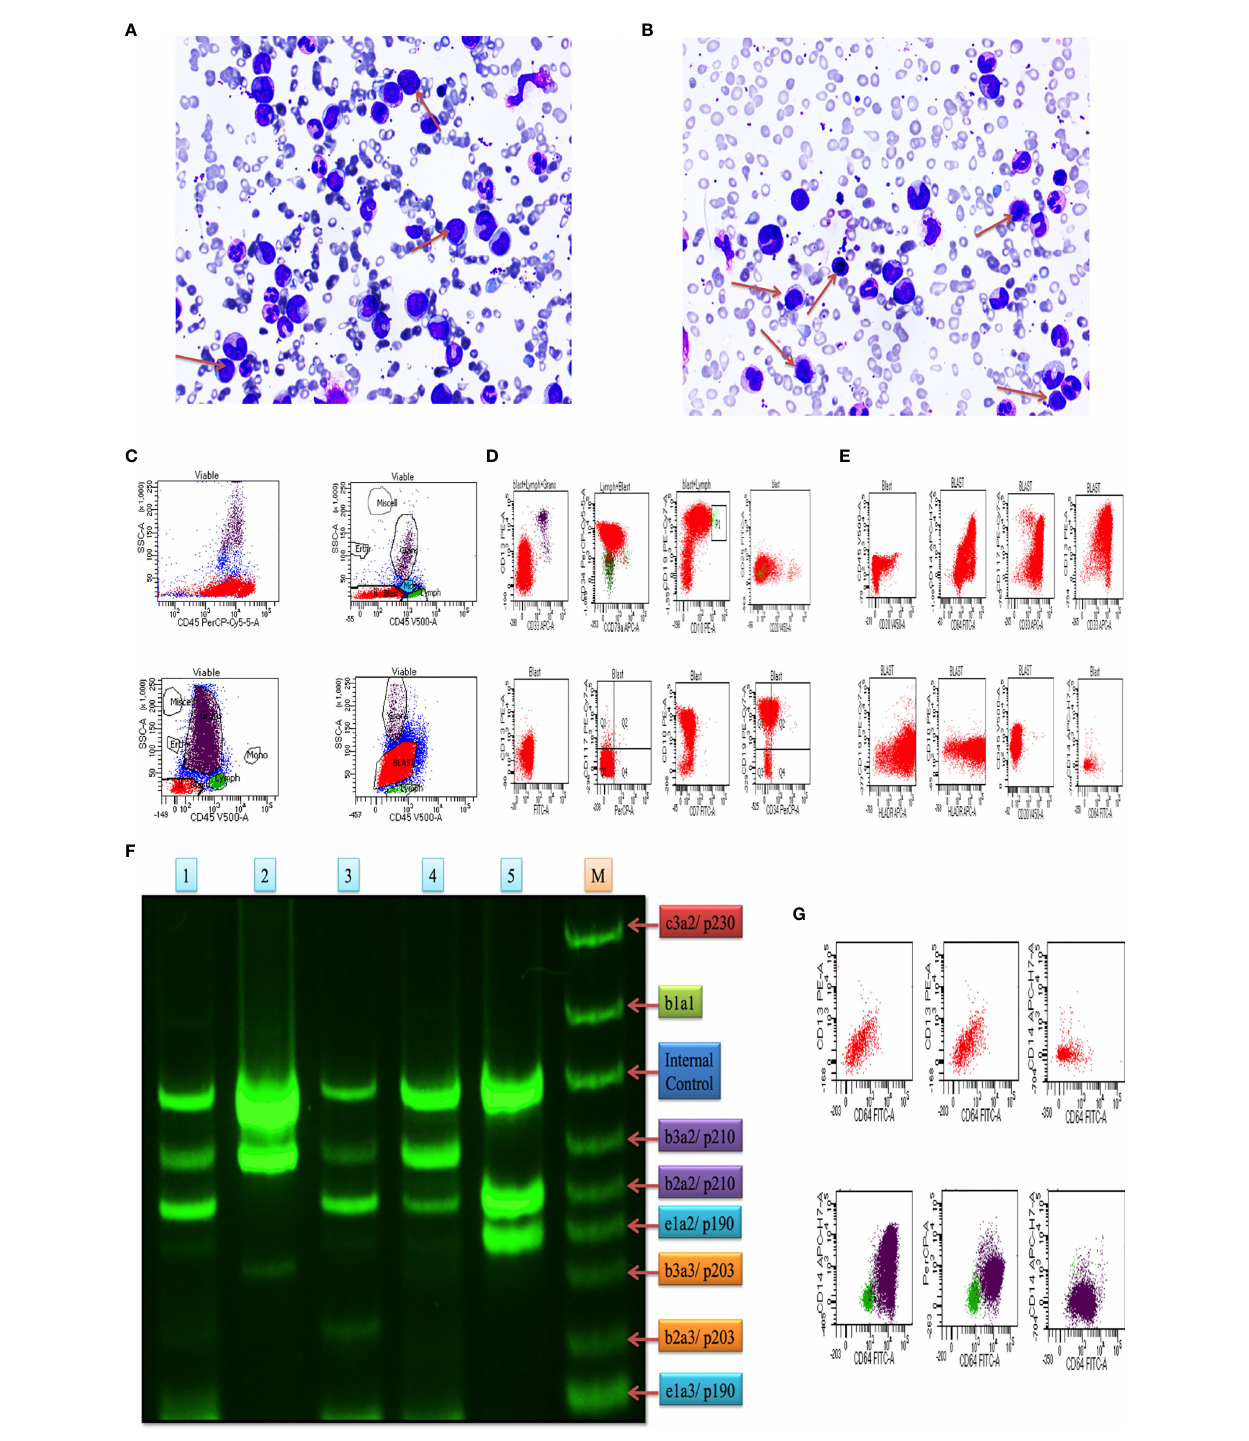
FIGURE 1 | Clinical diagnosis was con fi rmed on bone marrow aspiration, marrow trephine biopsy, and BCR/ABL1 translocation. (A, B) Representative images of Leishman staining of the blood of CML patients, where blast crisis cells are shown by the red arrow. (C) Flow cytometry results show the blast cells in various patients of CML patients, which were plotted on CD45 with side scatter and plotted on the marker and marker vs marker for the con fi rmation of CML (see also Figure S1 ). (D) the fi rst two rows of the scattered plot show the myeloid blast crisis cells, and other two rows show lymphoid blast crisis cells. (E) the scattered plot shows the blast crisis phase of chronic myeloid leukemia. (F) shows BCR/ABL1 translocation in CML patients, where lanes 1-5 show p210/p190 translocation, and lane M shows the standard of all kinds of translocation. (G) CD64 marker plot showing that it is present in all kinds of cells in CML patients and responsible for the production of ROS